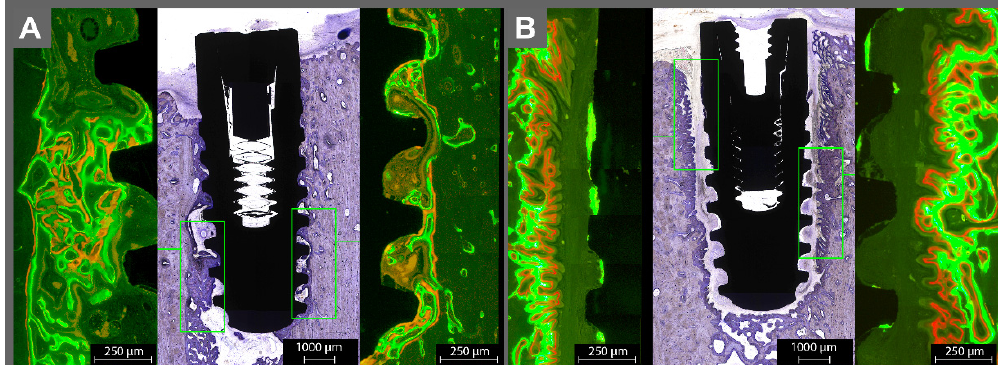
Figure 4. The histological examination of the ( A ) sterile and ( B ) contaminated implant into the basis mandible. Please note the lack of osseointegration around the contaminated implant. Around the sterile implants, the green and red fluorophores were overlapping and surrounding the implant without gaps, indicating healthy bone growth on the implant surface. Orange fluorescence was found on bone trabecula. On adjacent bone to the infected implants, almost no fluorescence was found on the implant surface, except in some areas with a very thin line of green fluorescence.